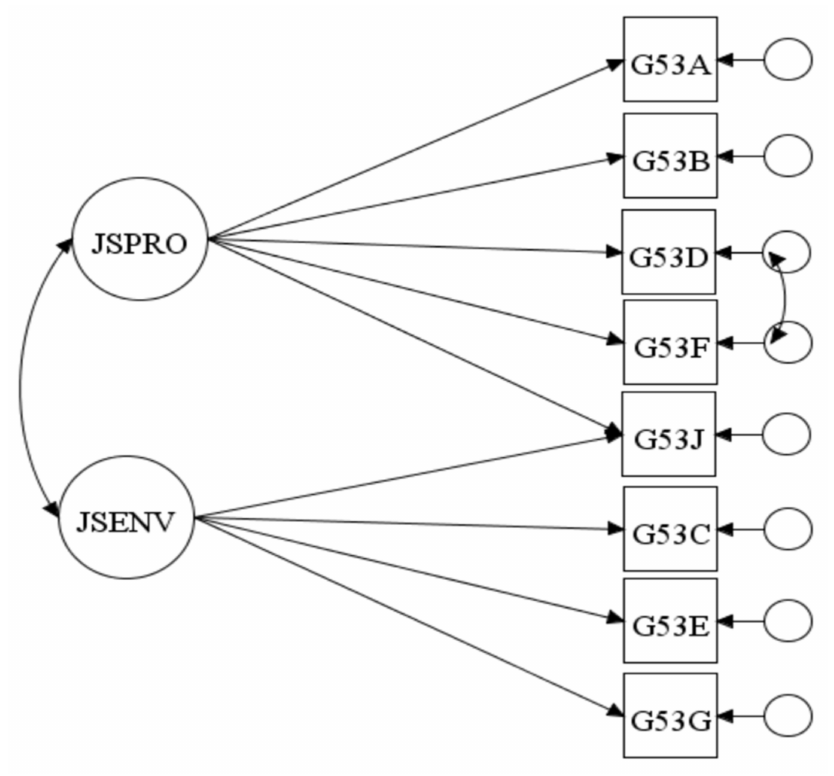
Figure 2. The second (proposed) measurement model of the two-factor teacher job satisfaction